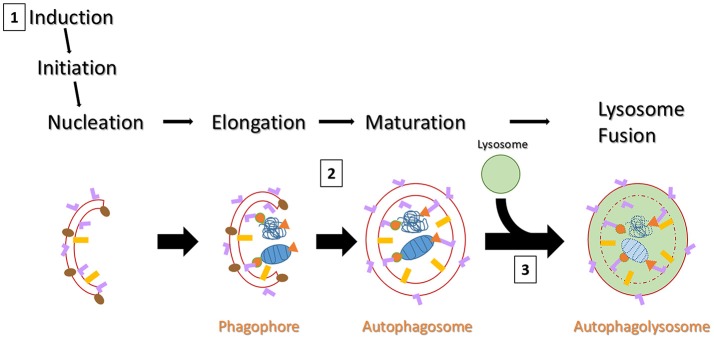
Schematic overview of autophagy. Autophagy can be induced by a chemical stimulus or by amino acid starvation. Upon induction of autophagy, LC3-I is cleaved into LC3-II (pink “L”) and an LC3-II positive membrane structure begins to form (usually on or near the endoplasmic reticulum). Meanwhile, GABARAP (gold rectangles) is expressed on the pre-autophagosomal structure during nucleation. GABARAP serves to recruit ULK1 (not pictured) and Beclin-1 (brown ovals). Beclin-1 serves as a scaffold protein to recruit more autophagy proteins and plays a key role in regulating autophagosome development. GABARAP then serves a similar role as LC3-II for cargo recruitment, but interacts with different cargo adaptors (not pictured) than LC3-II. As the membrane grows, various cargo are brought to the interior via cargo adaptor proteins (e.g., p62 or OPTN). Here, cargo is represented by a mitochondrion and a protein aggregate (both in blue) with orange p62 (triangles) and OPTN (tear drops) acting as cargo adaptors. The membranes fuse, forming a double-membraned autophagosome, marked by LC3-II on both inner and outer fuses with a lysosome and begins membranes. After maturity, the autophagosome lysosomal degradation of the inner membrane and all its constituents. There are three likely points of dysfunction that could result in detectable pathology in vivo: (1) failed induction would results in fewer autophagosomes being formed but little to no impact on expression and puncta formation of cargo adaptor proteins; (2) failed or delayed binding of LC3-II with cargo adaptor proteins would result in increased LC3 and cargo adaptor puncta, but decreased colocalized puncta; (3) failed lysosome fusion would result in all puncta being increased.